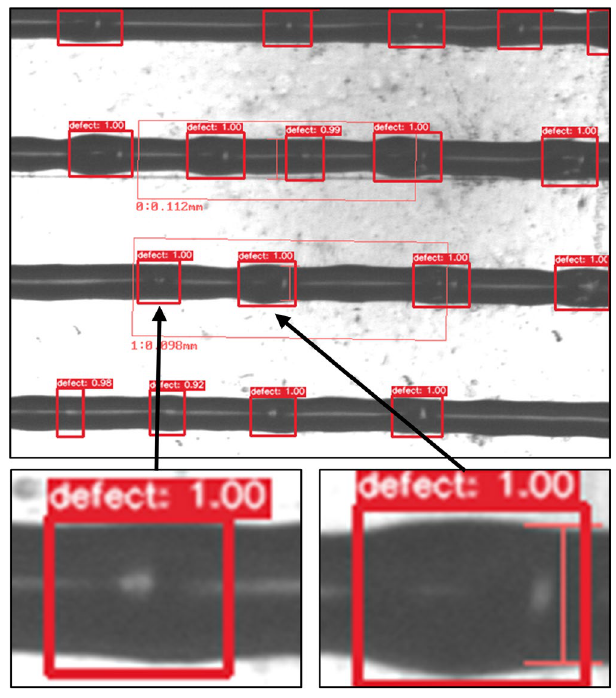
Figure 12. Detection example of YOLOv3 retrained object detection model.